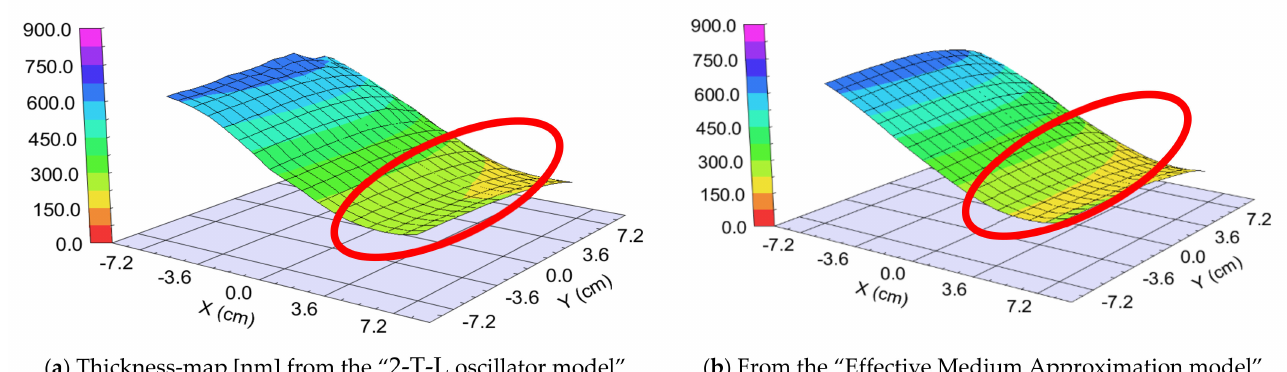
Figure 17. Thickness-maps ( a ) using the 2-Tauc-Lorentz (2-T-L) oscillator model ( b ) and the Effective Medium Approximation model. Red ellipses show the interesting area, where the composition changes the most. We show only one 15 × 15 cm part, all other parts show the same tendencies.